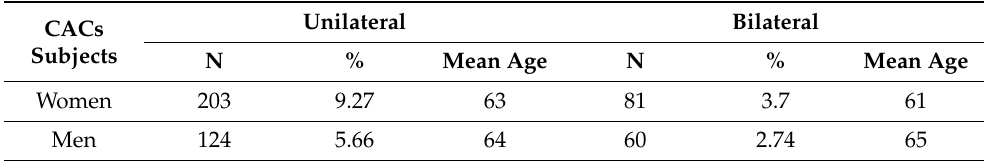
Table 1. Distribution of carotid artery calcifications in study group.